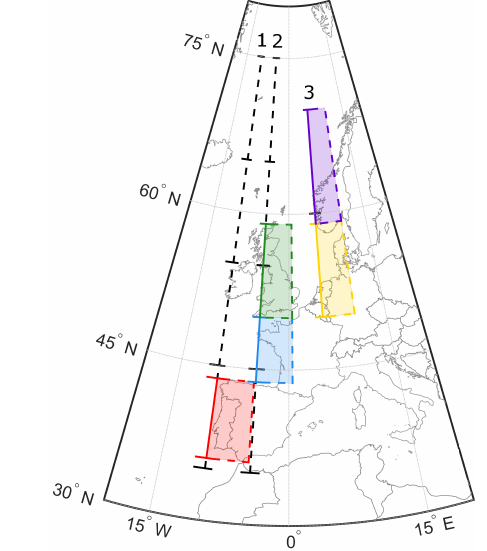
Figure 1. (a) Location of the three different reference meridians and sectors in Europe used for the computation of the atmospheric rivers. (b) The newly defined atmospheric river landfall domains: Iberian Peninsula (red), France (blue), UK (green), southern Scan- dinavia and the Netherlands (yellow), and northern Scandinavia (purple).